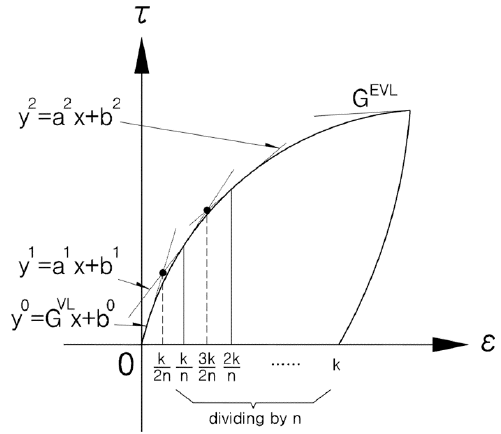
Figure 13. Numerical interpolation of a cyclic loop [16].